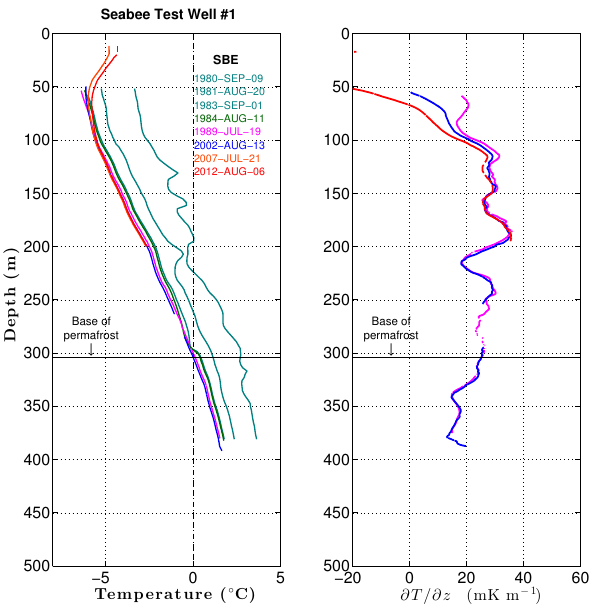
Earth Syst. Sci. Data www.earth-syst-sci-data.net